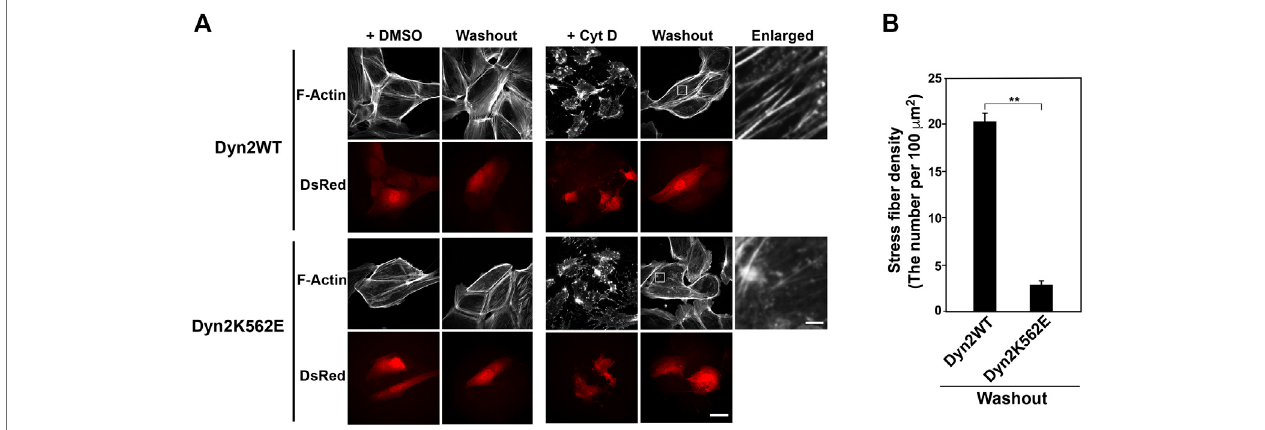
FIGURE 2 | Stress fi ber formation decreases in dynamin 2 (Dyn2)-K562E-expressing HPCs. (A) Double-immuno fl uorescence images of HPCs transfected with dynamin 2-WT or K562E cloned into the pIRES-DsRed2 vector as in Figure 1B . HPCs were treated with or without 5 μ M cytochalasin D (Cyt D) for 30 min. Washout experiments involved changing the Cyt D-containing medium with Cyt D-free medium. After 60 min, actin fi laments were stained with Alexa Fluor 488-phalloidin (Washout). Cells were treated with the solvent control (DMSO) solution represent the negative controls. Scale bars: 20 and 1.8 μ m in enlarged panels. (B) Stress fi ber density in dynamin 2-WT- or K562E-expressing HPCs after washing out of Cyt D. Data are means ± S.E.M. of 24 cells (dynamin 2-WT) or 27 cells (dynamin 2- K562E) from three independent experiments. (** p <